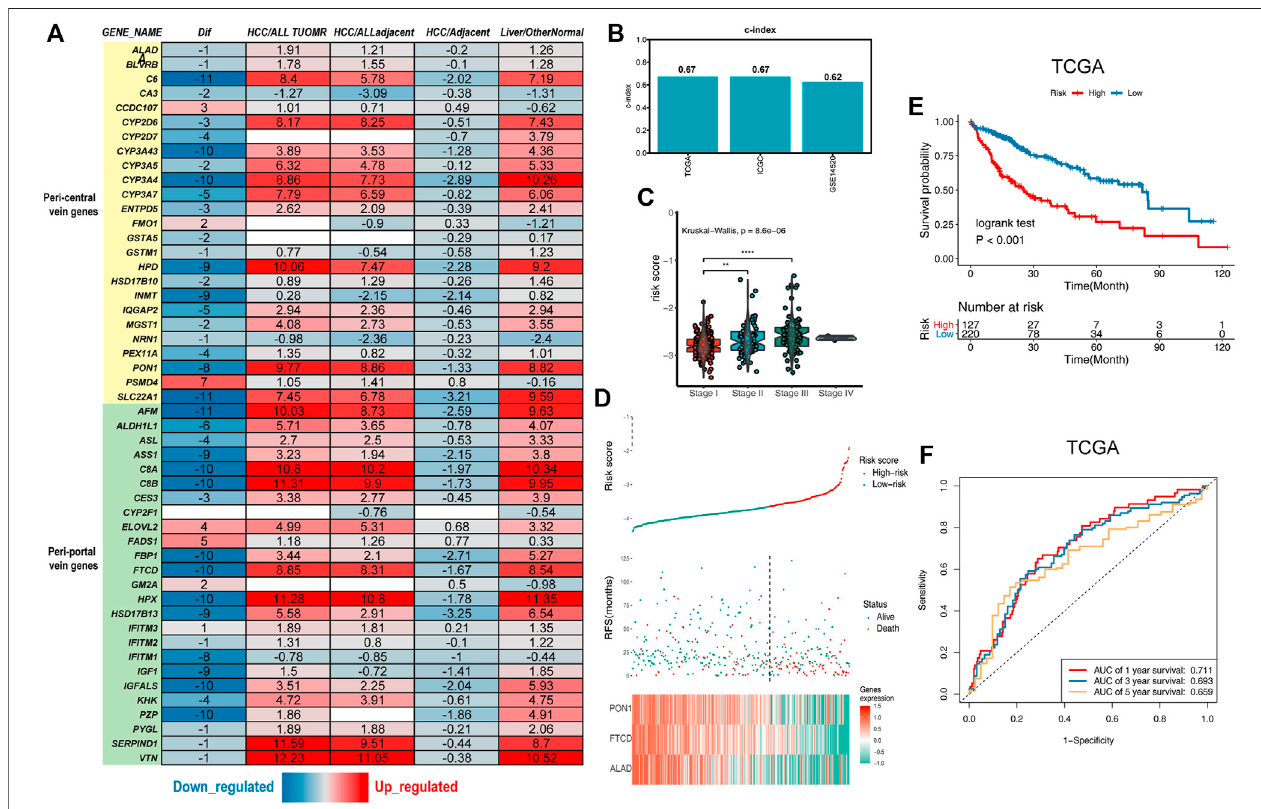
FIGURE 1 | Establishment of the liver zonation-related prognostic signature. (A) Summary of liver zonation-related genes. Dif: The number of differentially expressed datasets. Red/blue for consensus upregulated/downregulated. HCC/AllTumor: red/blue for the positive/negative fold change in log2 scale by comparing HCC with all tumors (TCGA data). HCC/AllAdjacent: red/blue for the positive/negative fold change in log2 scale by comparing HCC with all adjacent samples (TCGA data).HCC/Adjacent:red/blueforthepositive/negativefoldchangeinlog2scalebycomparingHCCwithadjacentsamples(HCCDBdata).Liver/OtherNormal:red/ blueforthepositive/negativefoldchangeinlog2scalebycomparingliverwithnormaltissues(GTExandTCGAdata). (B) C-indexofthethree-genesignaturewas0.67in the TCGA cohort, 0.67 in the ICGC cohort, and 0.62 in the GSE14520 cohort. (C) Violin diagram showing higher risk scores for the higher tumor stage. (D) Top graphs show the distribution of risk scores; the center graphs show the survival status of patients in the training cohorts; the bottom graphs show expression patterns of the three genes. (E) Kaplan – Meier plot of the three-gene signature in TCGA cohort. (F) tROC curve of the three-gene signature in TCGA.